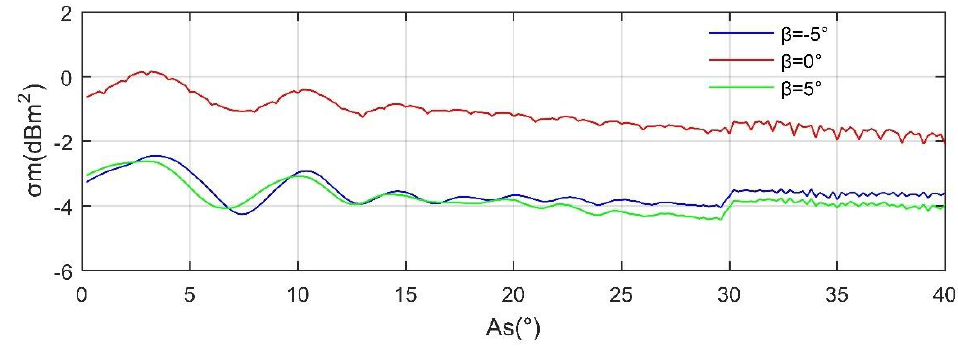
Figure 12. Average RCS of the aircraft obtained by FAM, where α n = 90° , α m = 150°, and F rv =5